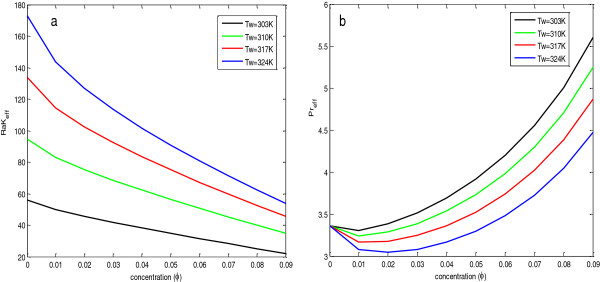
Effective Prandtl number(a)and modified Rayleigh number(b)of Al2O3 + H2O nanofluid with concentration.